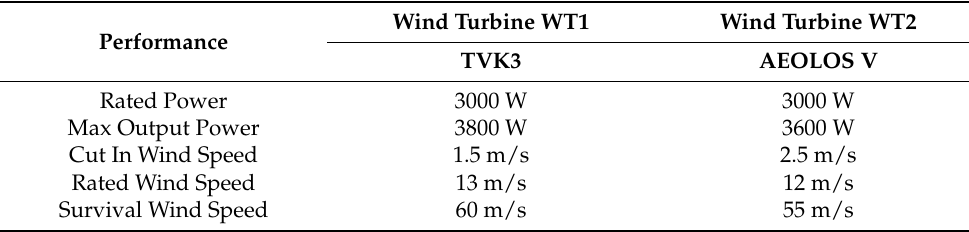
Table 1. Selected technical data of the analyzed turbines.